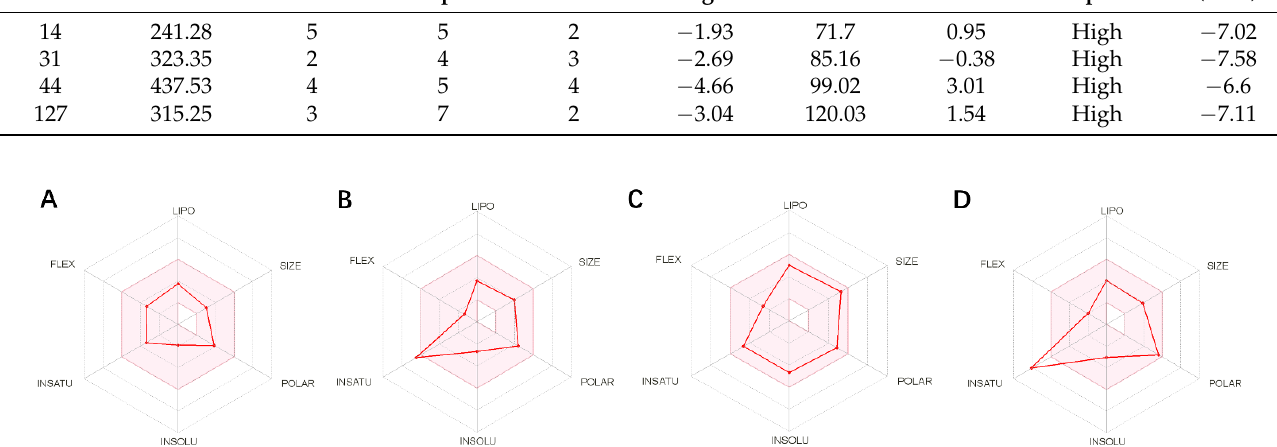
Figure 7. ADME properties of compounds obtained after the covalent screening. ( A ) ADME prop- erties of compound 14 ; ( B ) ADME properties of compound 31 ; ( C ) ADME properties of compound 44 ; ( D ) ADME properties of compound 127 .